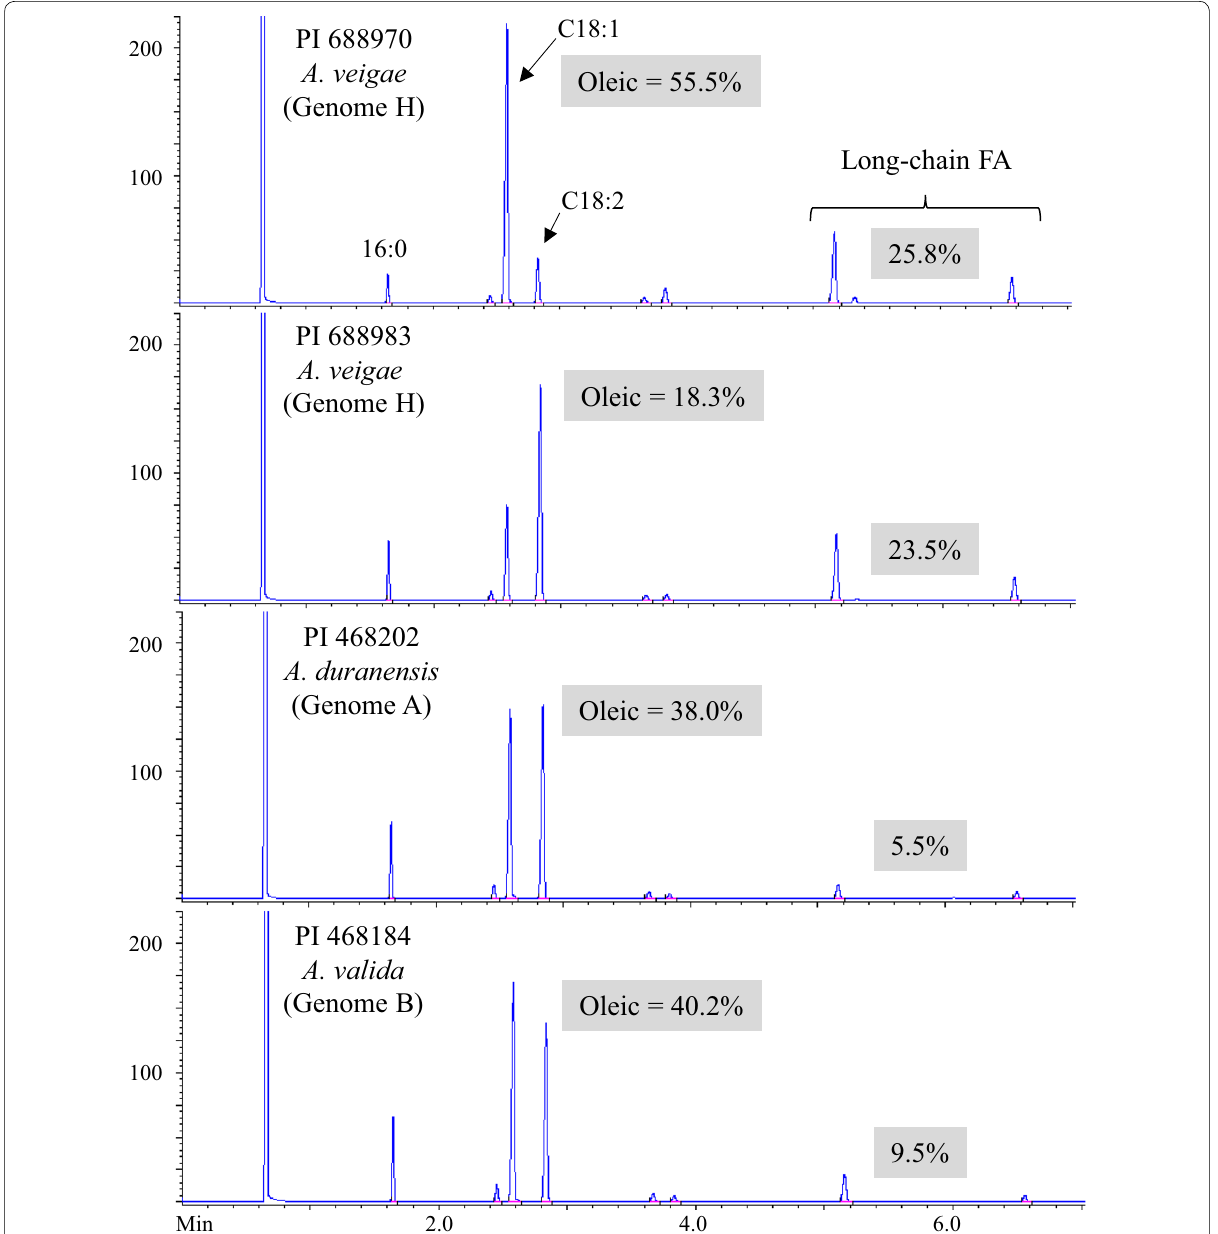
Fig. 1 Comparison of fatty acid profiles among four different wild peanut accessions on